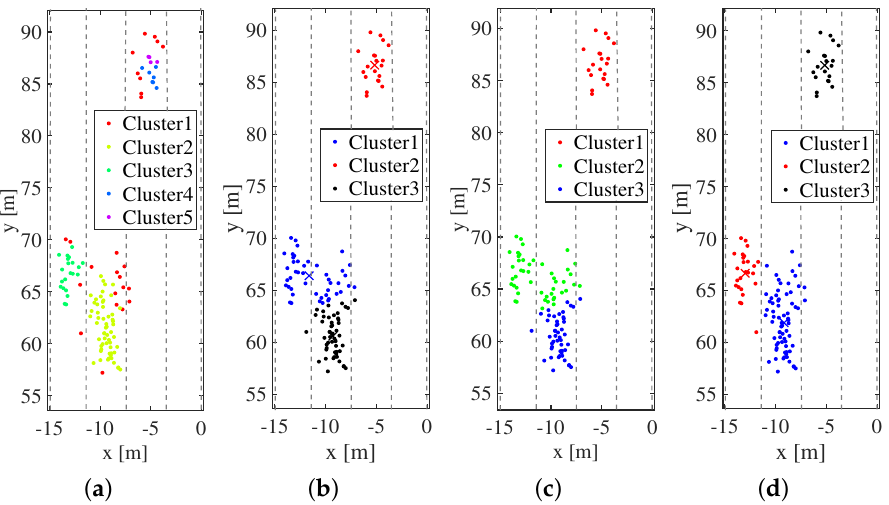
Figure 12. The clustering results of each algorithm: ( a ) DBSCAN; ( b ) FCM; ( c ) K-Means; and ( d ) SDPFC.